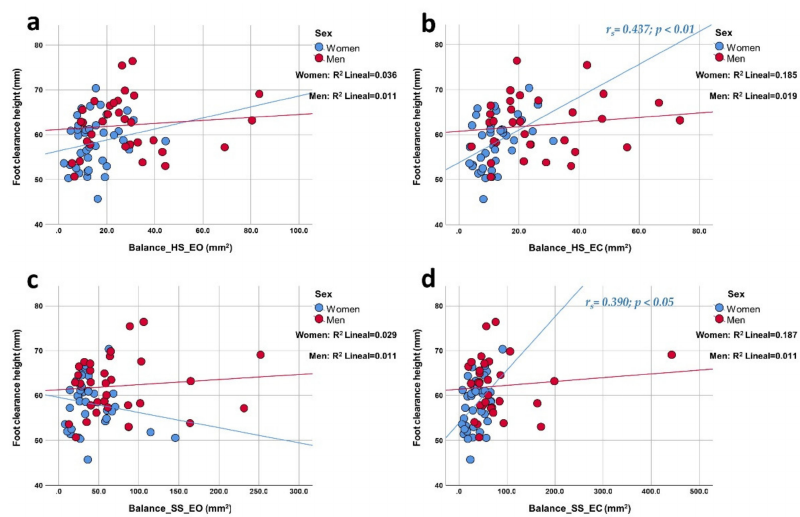
Figure 4. Correlation plots of foot clearance height compared to balance area in each of the tests. Each image shows the correlations obtained distributed by sex. The upper part of the figure shows the results for a hard surface with eyes open (panel ( a ); linear R 2 women: 3.6%; men: 1.1%) and closed eyes (panel ( b ); linear R 2 women: 18.5%; men: 1.9%); the lower part shows the results for a soft surface with open eyes (panel ( c ); linear R 2 women: 2.9%; men: 1.1%) and closed eyes (panel ( d ); linear R 2 women: 18.7%; men: